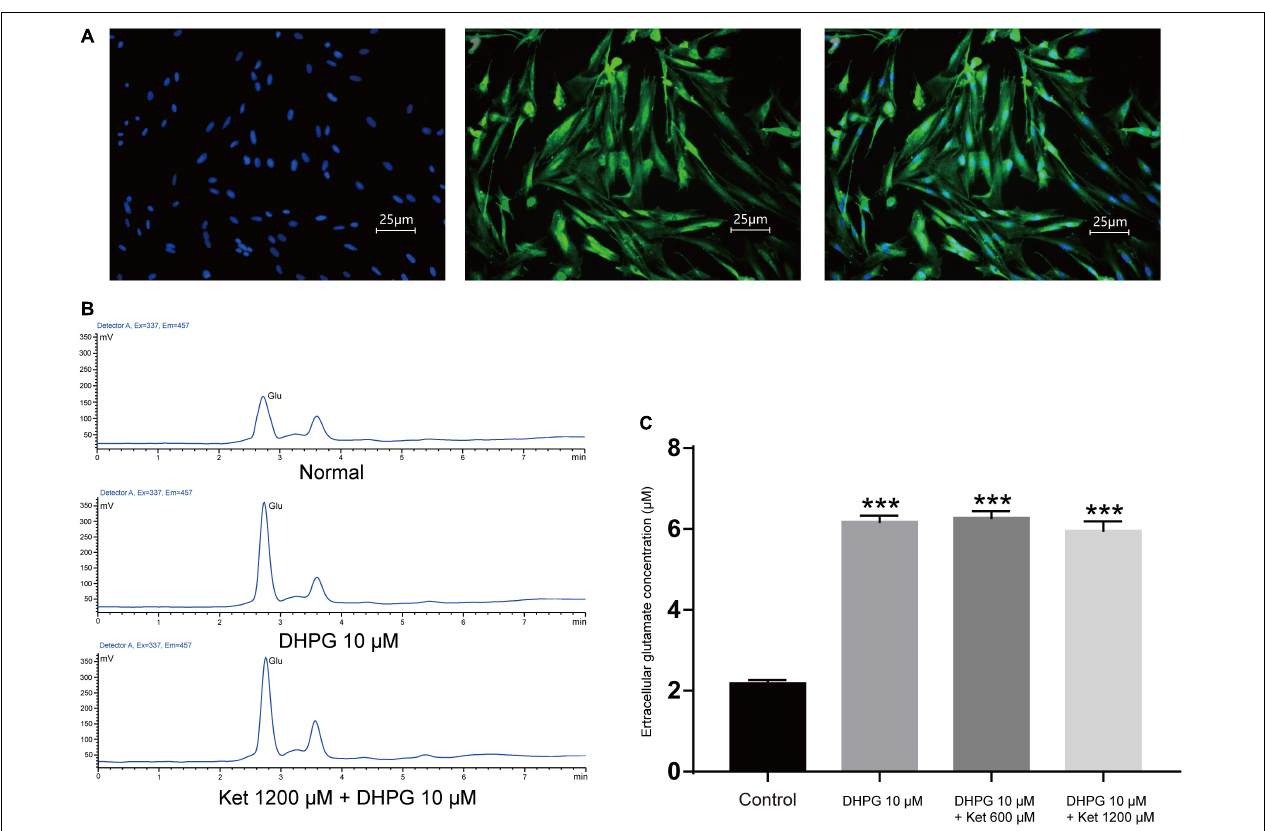
FIGURE 4 | Effect of ketamine on glutamate release from cultured prefrontal cortex astrocytes. (A) Micrographs of cultured prefrontal cortex astrocytes labeled for DAPI (left), GFAP (middle) their overlay (right). (B) HPLC chromatogram of glutamate in astrocyte culture medium after DHPG (middle) or ketamine (down) administration. (C) Statistical summary of the glutamate concentration. Differences with statistically significant ( ∗∗∗ p < 0.001, compared with control) were verified by one-way ANOVA followed by Brown-Forsythe test. Data were presented as mean ± SD. Glu = glutamate, Con = control, Ket =